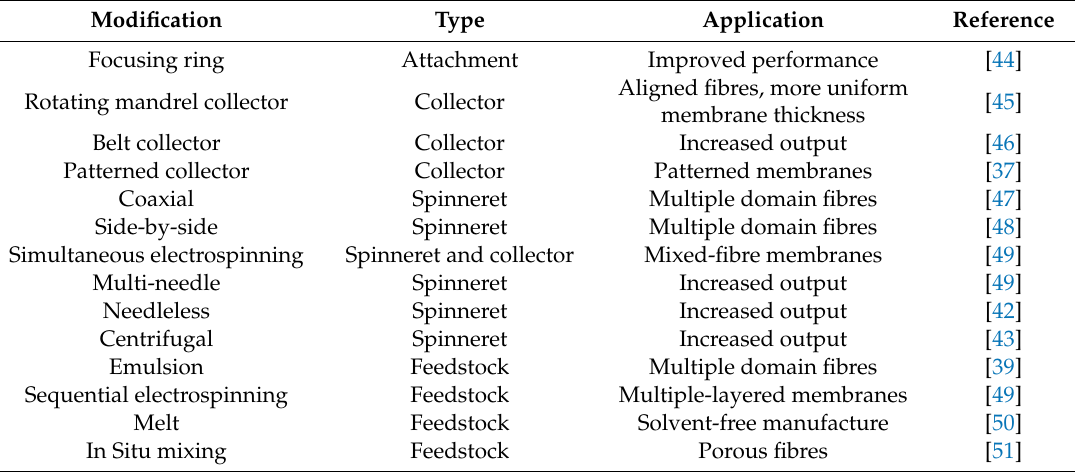
Table 1. Variations and modifications to the electrospinning